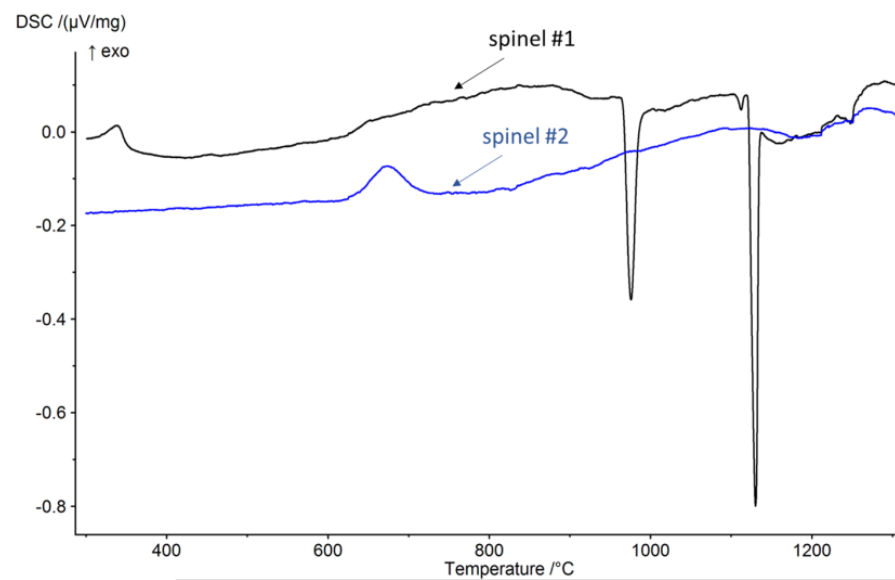
Figure 8. DSC curves of as-received spinel #1 and newly formed spinel #2 (Table 1). The CuMnFe spinel exhibits two major endothermic reactions at 950 and 1150 °C, whereas the AlFeCuMn-spinel is stable in this temperature range. in as received condition, after coating and thermal aging, are plotted in Figure 9.